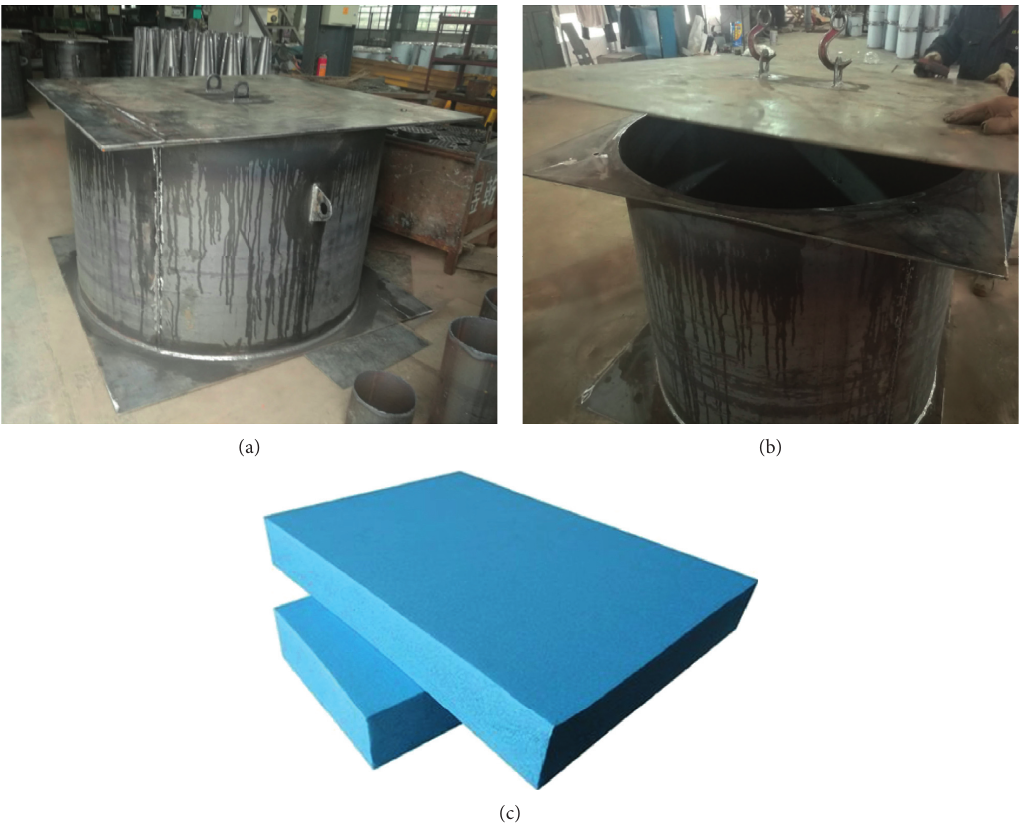
Figure 2: Photos of the CFST members evaluated in this study. (a) 1.4m diameter. (b) 1.6m diameter. (c) Hard adiabatic foam. Table 1: Mixing proportion of C55 nonshrinkage concrete (kg/m 3 ).